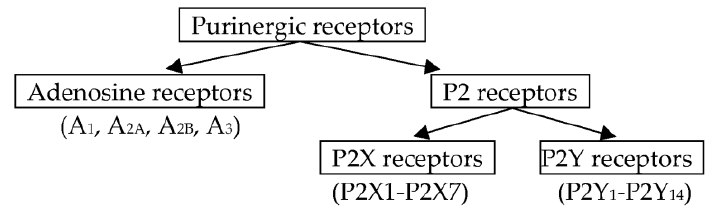
Figure 1. Classification of the receptors for purines.